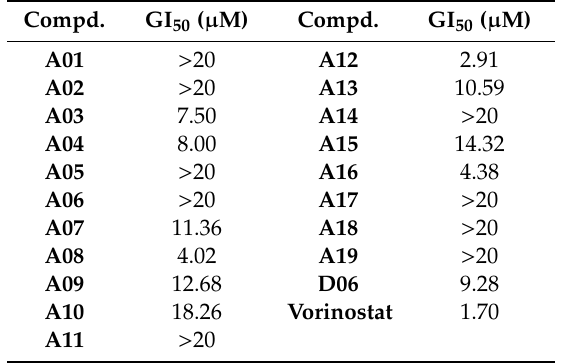
Table 3. The antiproliferative activities of target compounds against PC-3 cells. Compd. GI 50 ( µ M)